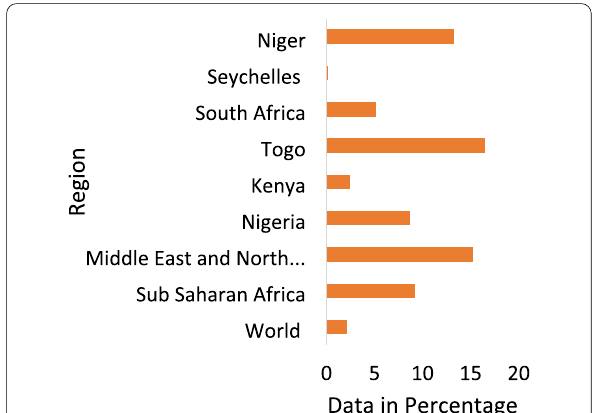
Fig. 1 Total natural resources rent in percentage of GDP as at 2017